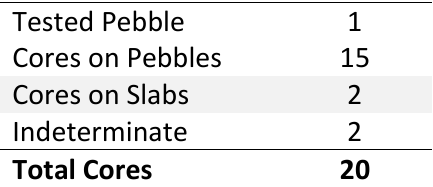
Table 3. Number of cores.